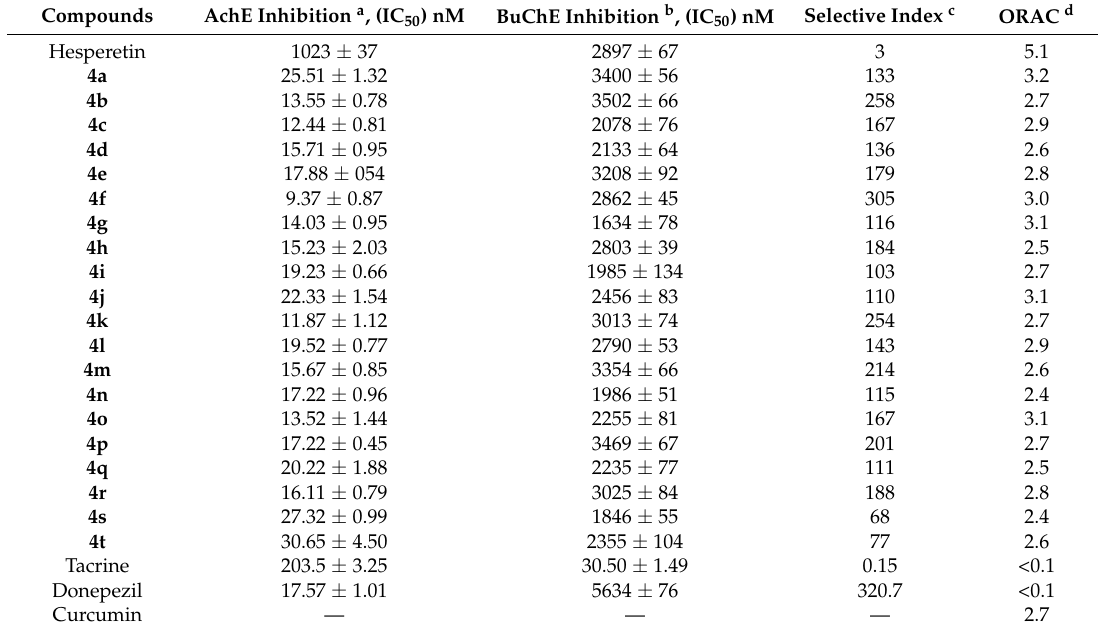
Table 1. In vitro inhibition of AChE, BuChE and oxygen radical absorbance capacity (ORAC, Trolox equivalents) of the synthesized hesperetin derivatives.